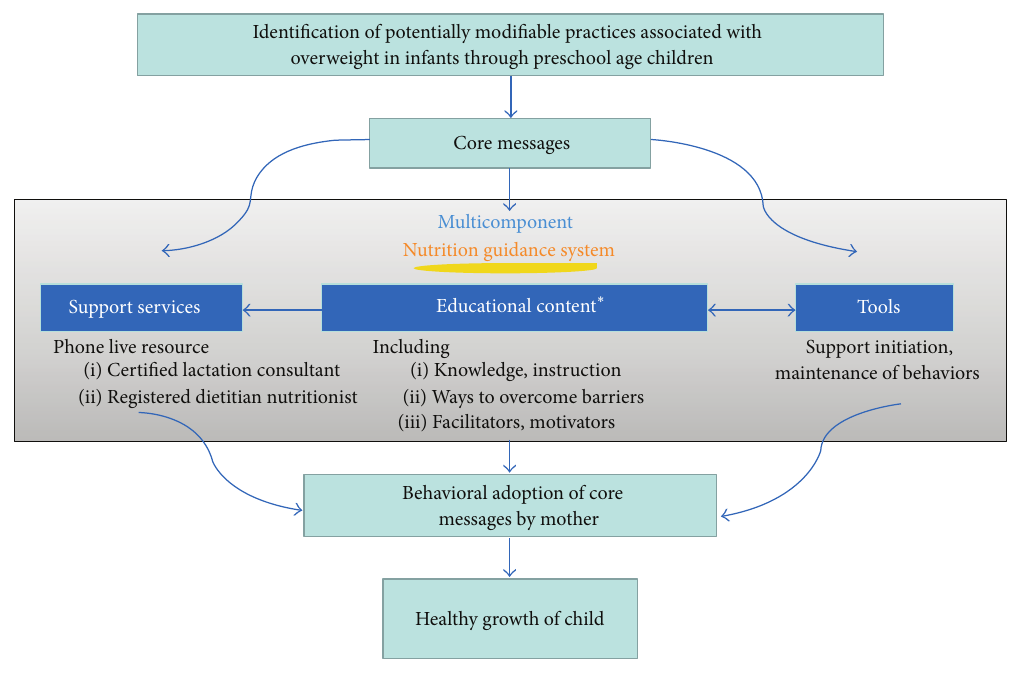
Figure 2: Conceptual framework for the nutrition guidance